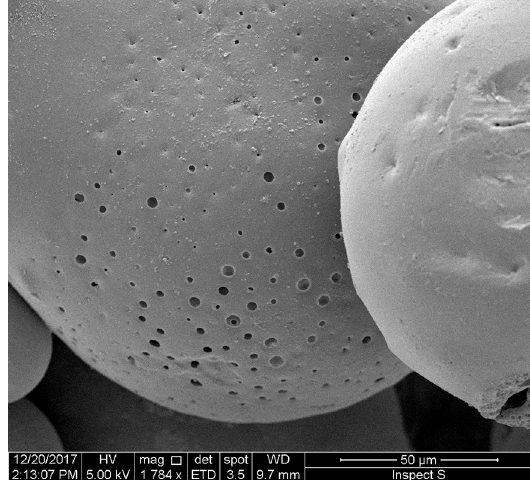
Figure 3. SEM image of PVAc -Rhodamine microspheres.